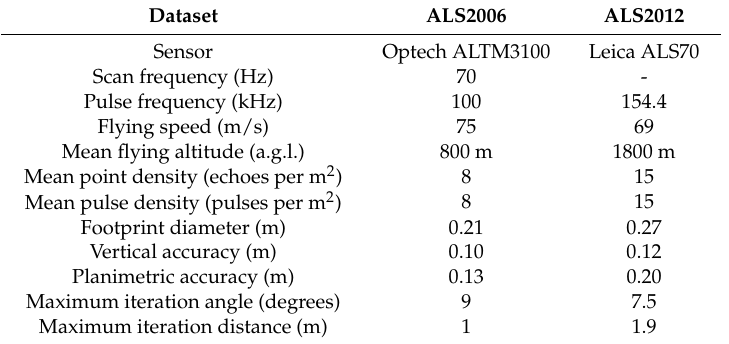
Table 2. Specifications of the two ALS datasets. Mean echo and pulse density calculated from the data, information in the other fields from the data vendor.